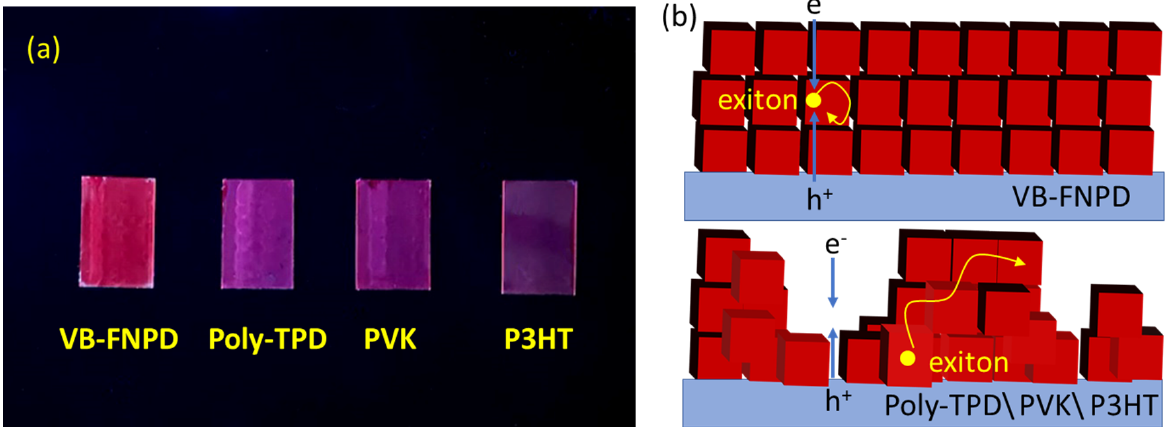
Figure 3. ( a ) CsPbI3 QDs films deposited on 9,9-Bis[4-[(4-ethenylphenyl)methoxy]phenyl]-N2,N7-di-1-naphthalenyl-N2,N7-diphenyl-9H-fluorene-2,7-diamine (VB-FNPD), Poly(N,N ′ -bis-4-butylphenyl-N,N ′ -bisphenyl)benzidine (Poly-TPD), poly(9-vinycarbazole) (PVK) and crystalline Poly(3-hexylthiophene-2,5-diyl) (P3HT) and excited under UV light at 365 nm. ( b ) The illustration of the QD aggregations on different HTLs.